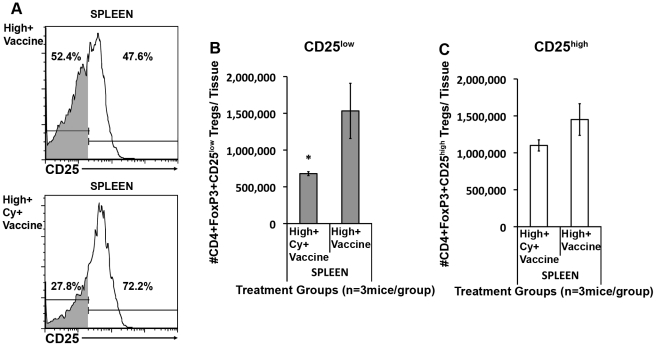
Cy preferentially depletes CD25lowFoxp3+ Tregs.
Neu-N mice were treated as in 
Figure 3
 and the Methods. Lymphocytes from spleens were collected on day 3. (A) CD4+Foxp3+ Tregs were analyzed for CD25 expression. Definition of CD25high vs. CD25low is based on isotype control. CD25low cells = gray fill under the histogram. (B) Absolute # CD25lowCD4+Foxp3+ Tregs calculated in spleens. (C) Absolute number of CD25highCD4+Foxp3+ Tregs calculated in spleens. High = high avidity T cell transfer, Cy = Cyclophosphamide treatment, Vaccine = 3T3neuGM vaccine treatment. * = p<0.05. These studies were repeated three times with similar results (n = 3 mice/group).